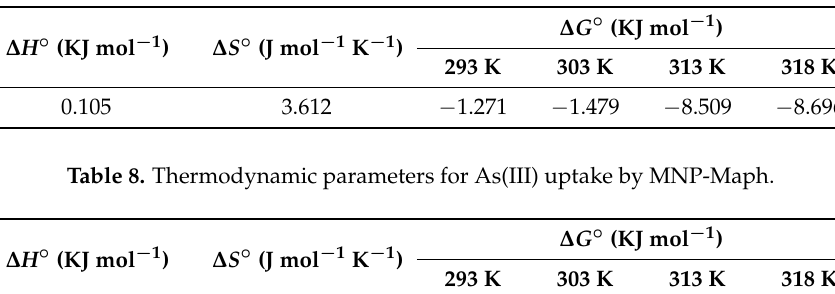
Table 7. Thermodynamic parameters for Zn(II) uptake by MNP-Maph.